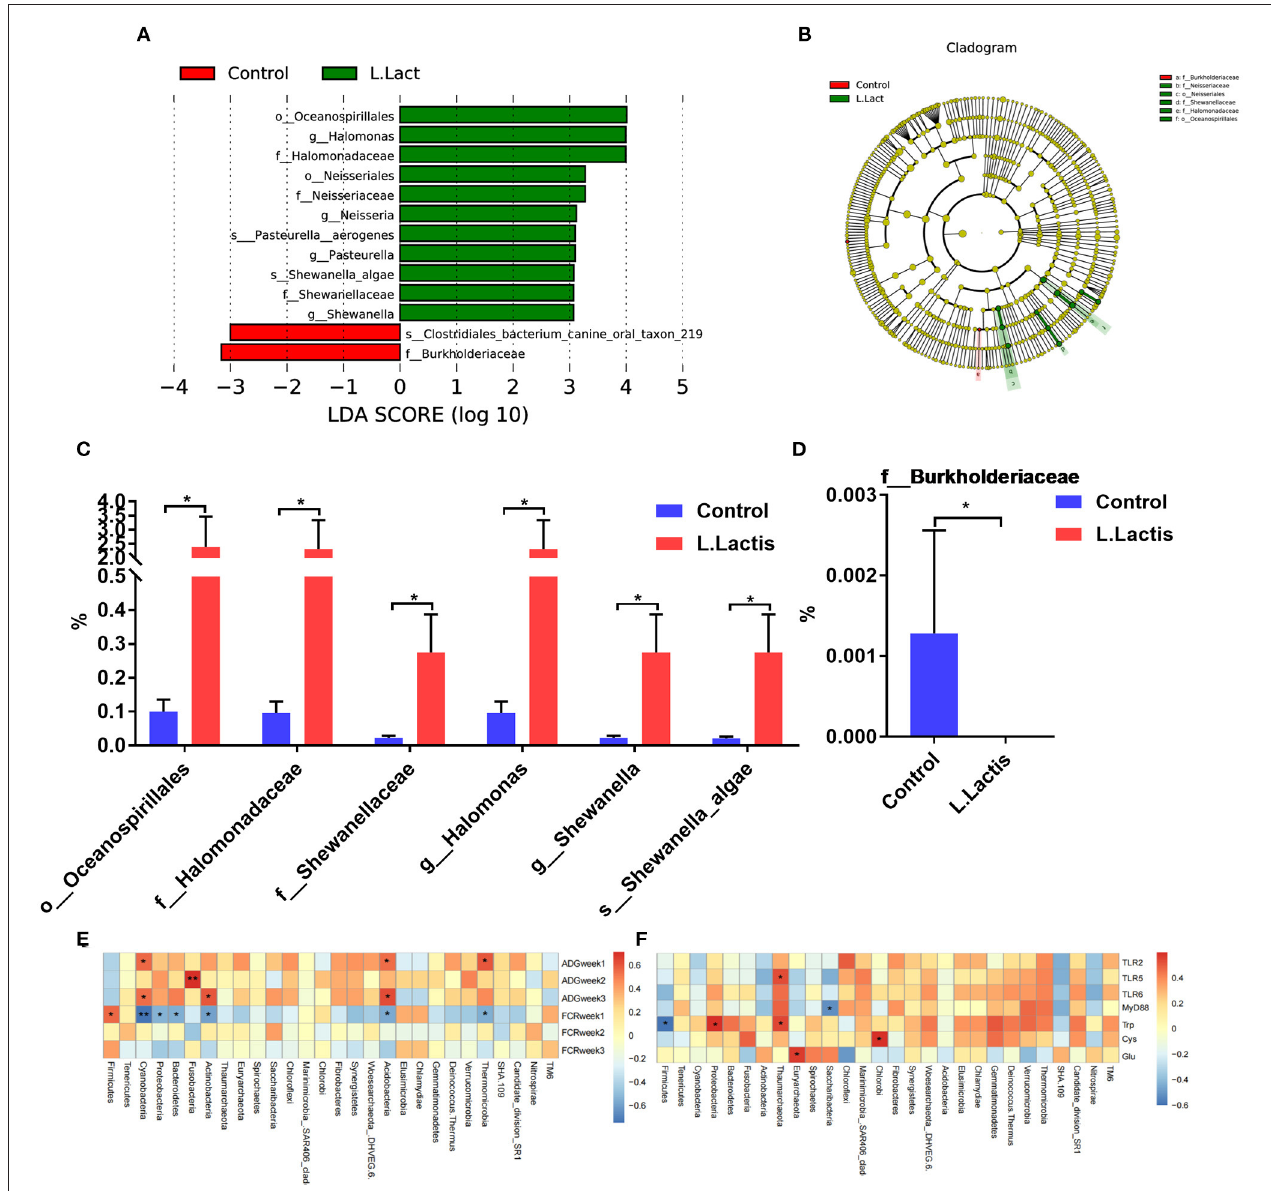
FIGURE 5 | L.lactis regulated the ileal microbiota of the piglets. (A–D) LEfSe analysis demonstrated the significant members in the control and L.lactis groups. (E) Environmental factor correlation analysis indicated that ADG of week 2 was positively correlated with Fusobacteria. (F) Ileal TLR-5 mRNA expression and serum tryptophan (Trp) level were positively correlated with the relative abundance of Thaumarchaeota ; serum Trp level was also positively correlated with the relative abundance of Proteobacteria . * P < 0.05; ** P <